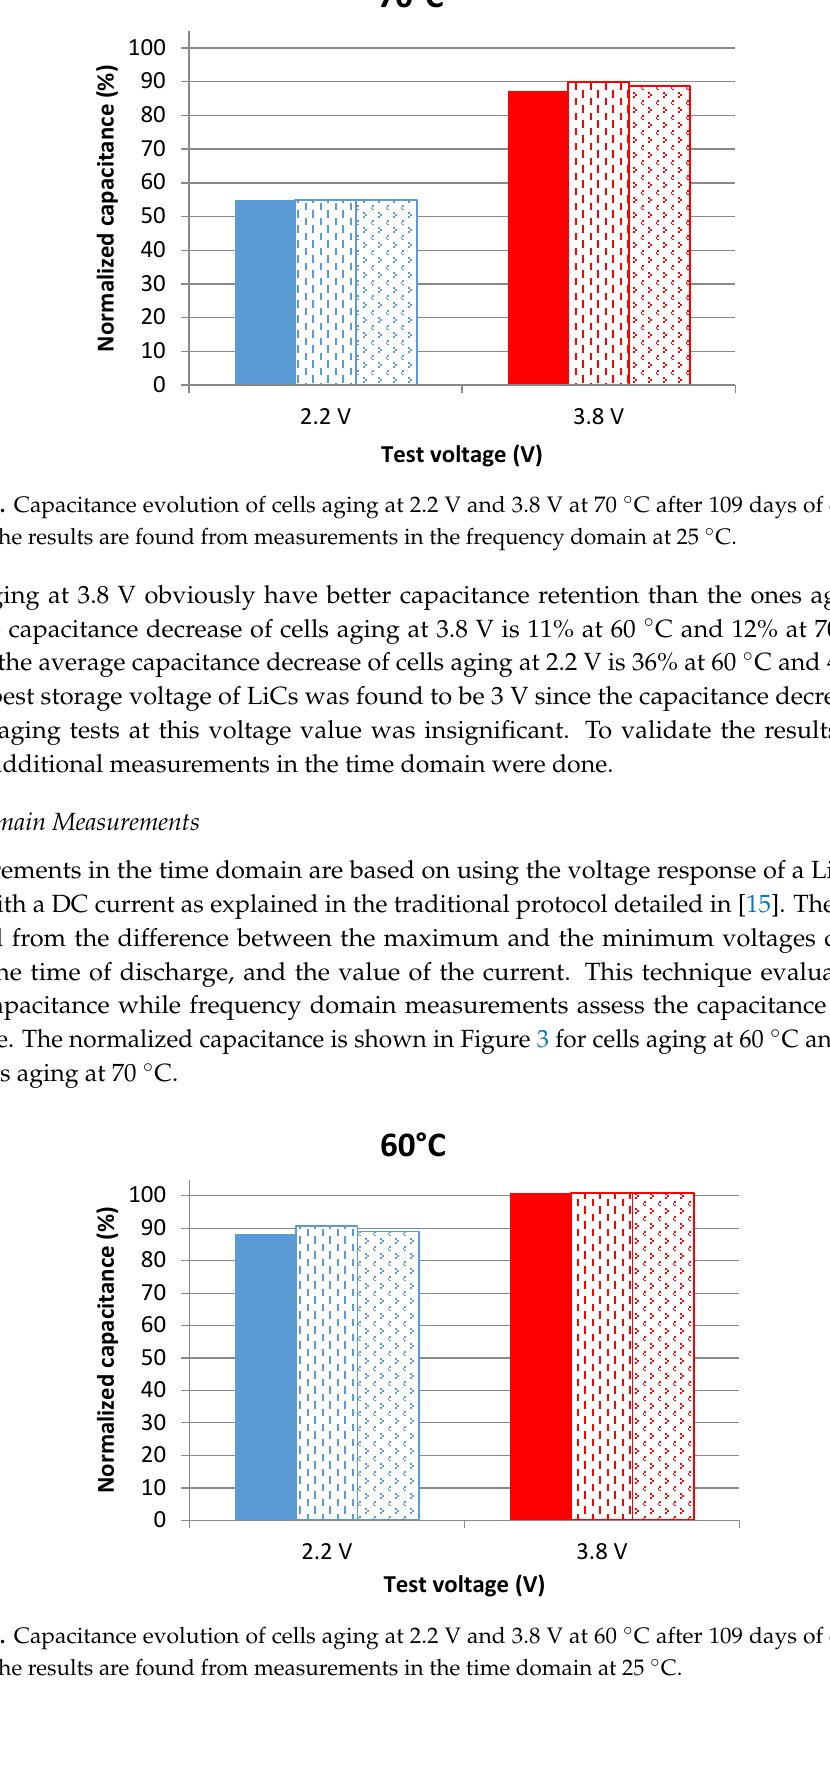
Figure 4. Capacitance evolution of cells aging at 2.2 V and 3.8 V at 70 °C after 109 days of calendar aging. The results are found from measurements in the time domain at 25 °C. Results of time domain measurements show that LiCs aging at 3.8 V barely age since their capacitance does not decrease even after being for 109 days under calendar stresses. The capacitance decrease of cells aging at 2.2 V is also much less than the one found in frequency domain measurements. For this reason, the capacitance of a cell aging at 3.8 V at each voltage value, during its discharge with a DC current, was measured according to the method explained in [15]. A comparison between the evolution of the capacitance with respect to the voltage before and after aging is presented in Figure 5.